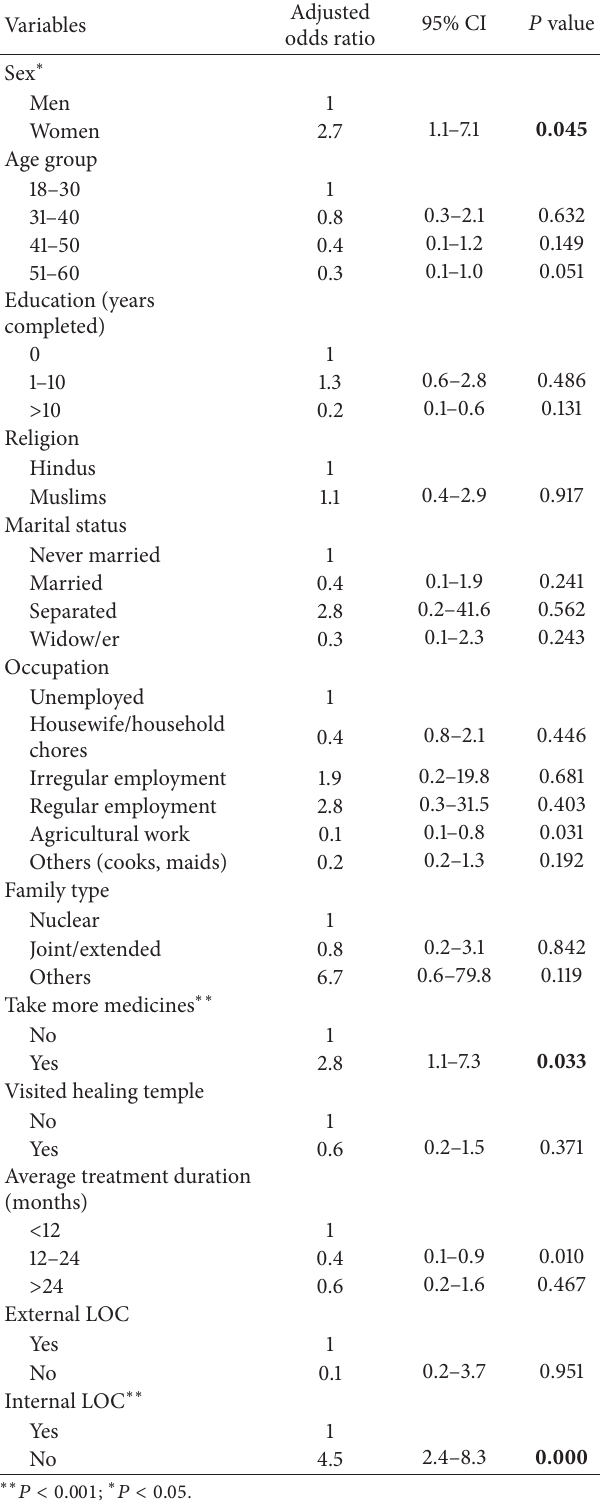
Table 10: Factors associated with poor adherence: multiple logistic